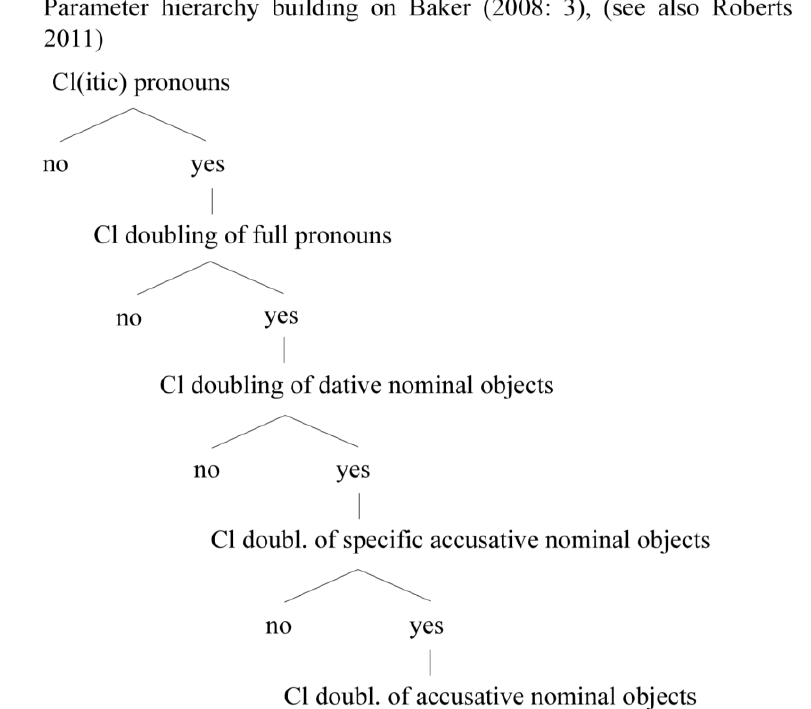
Figure 1: Parameter hierarchy proposed by Fischer and Rinke (2013: